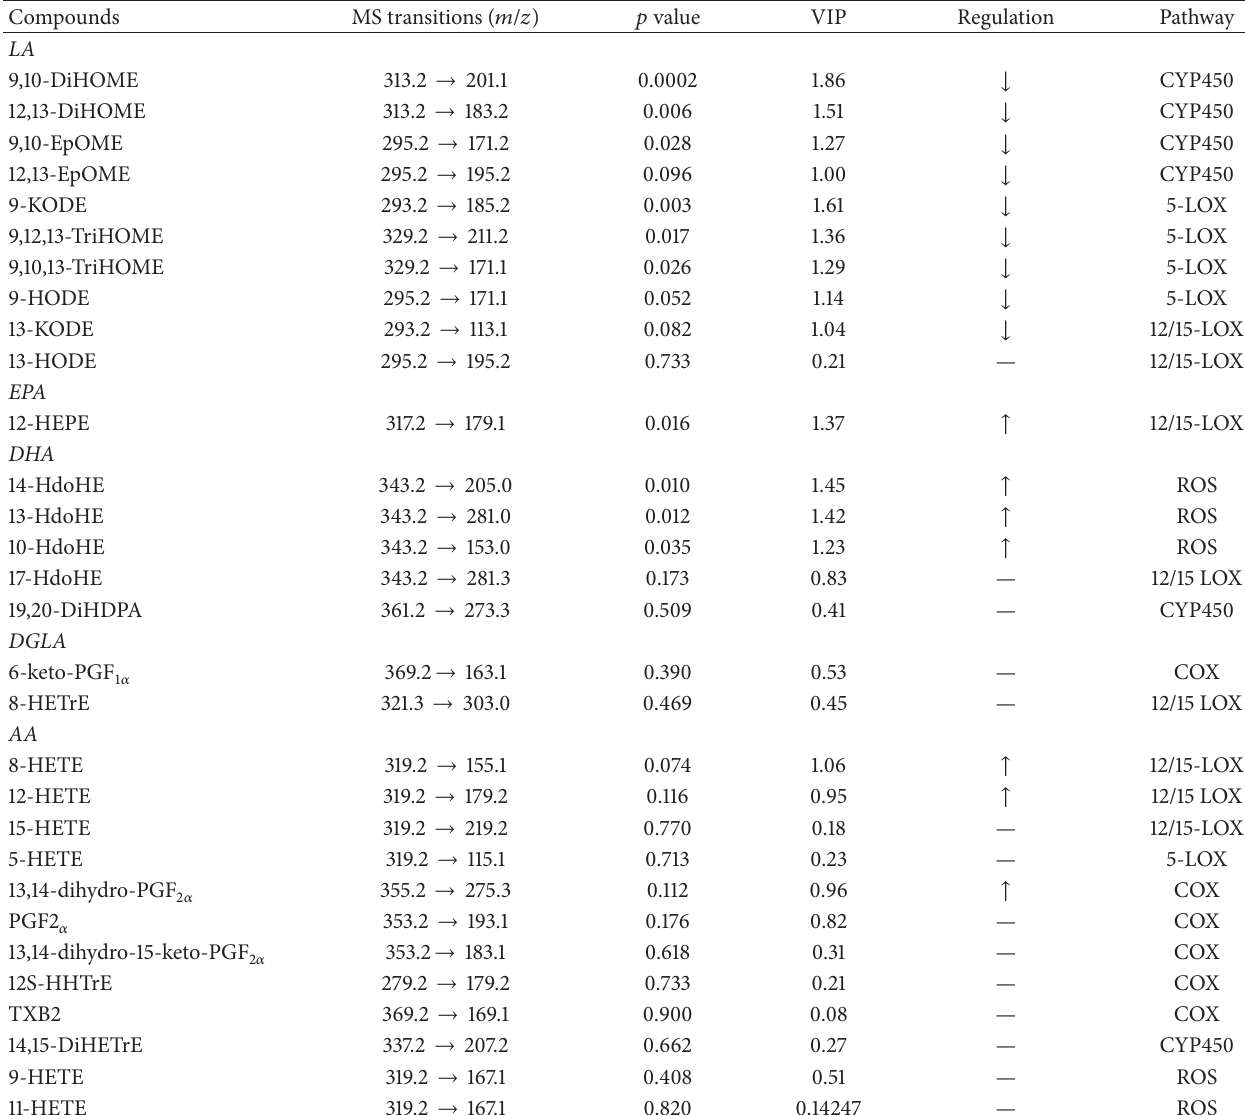
Table 1: List of oxylipins detected in mice plasma, measured by multiple reaction monitoring (precursor ions → product ions) in LC-MS/MS